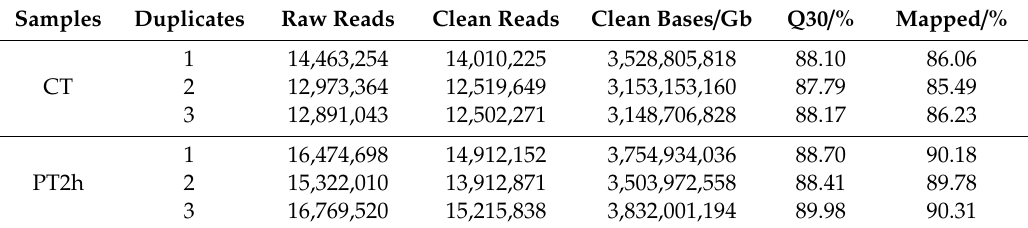
Table 1. Summary of sequencing data and mapped results in this